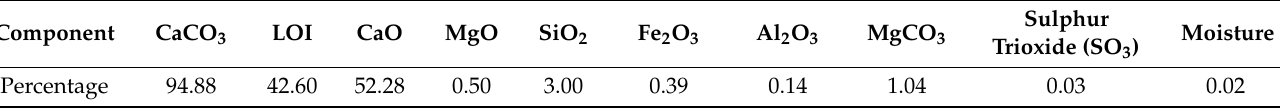
Table 3. Chemical composition of marble